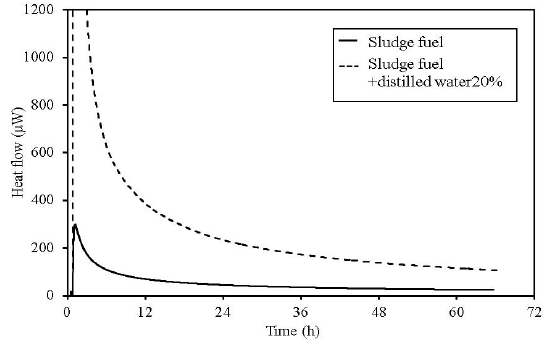
Figure 12. TAM calorimetry curves for sludge fuel.